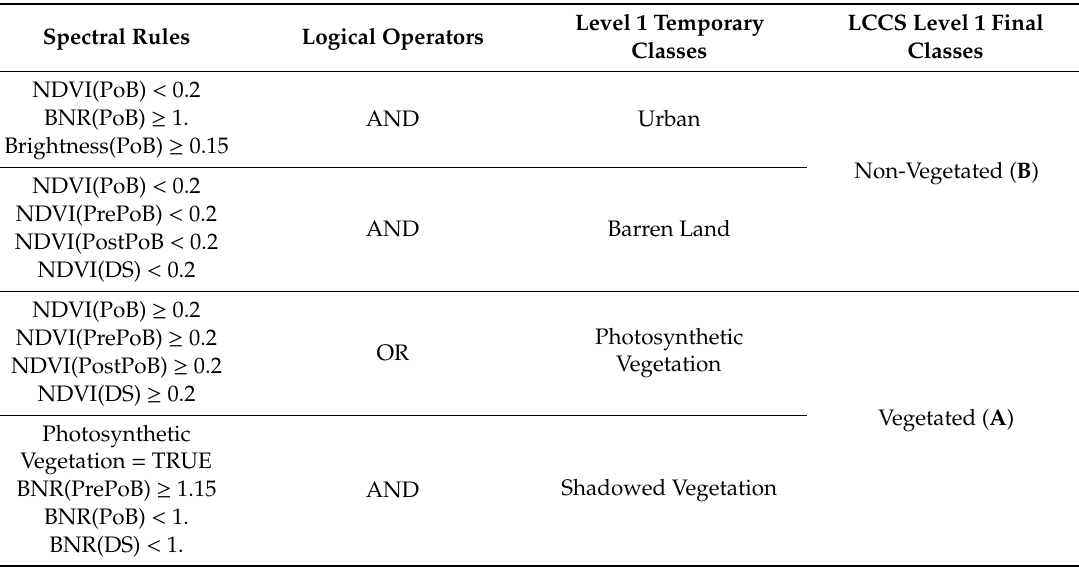
Table 5. Rules used for Level 1 LCCS classification.